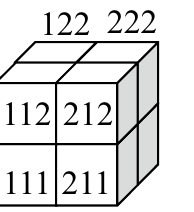
Fig. 4 The SEA model of the system shown in Fig. 3 (The blue arrows represent power inputs, the black arrows represent power flows between different subsystems through couplings, and the red arrows represent the powers dissipated due to internal damp- ing)